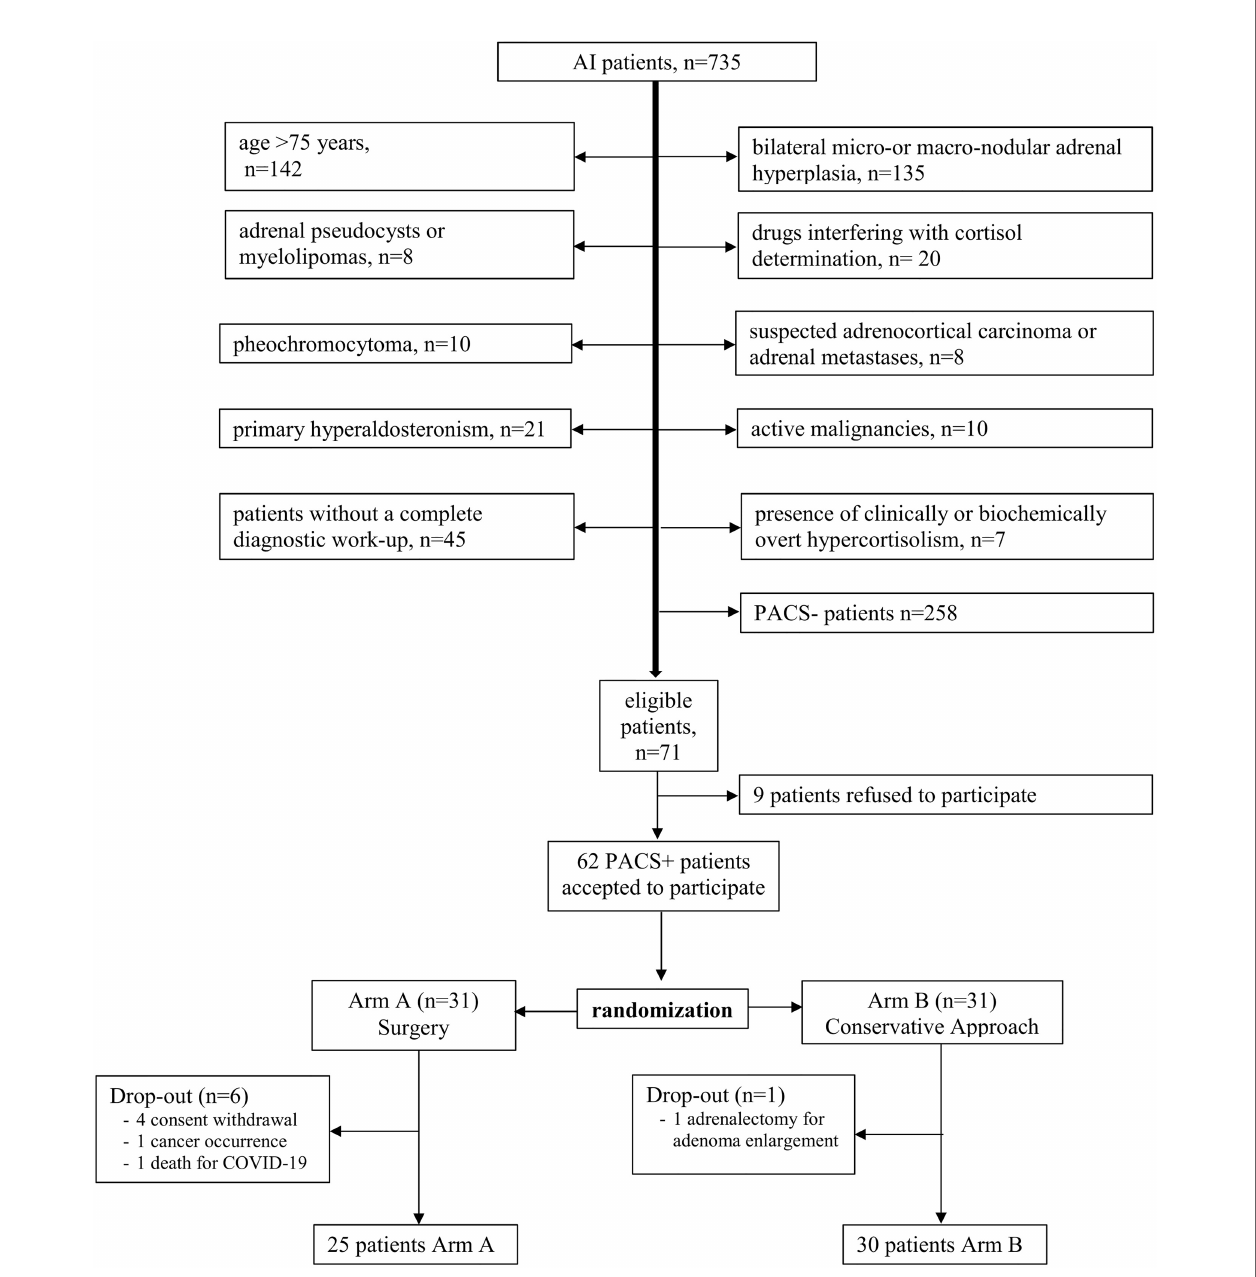
FIGURE 1 | Enrollment procedure. AI, adrenal incidentaloma; PACS, possible autonomous cortisol secretion; PACS+, patients with possible autonomous cortisol secretion; PACS-, patients without possible autonomous cortisol